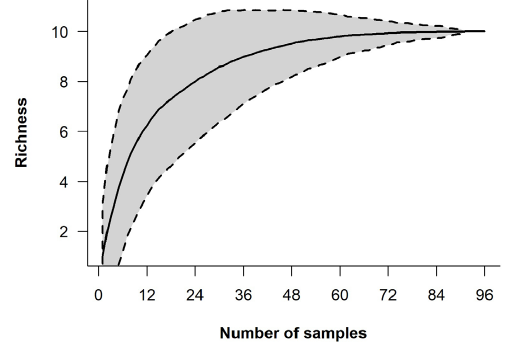
Figure 2. Cumulative richness of immature stages of Odonata (Insecta) in the Municipal Park of Lagoa do Peri (PMLP; Santa Catarina Island, southern Brazil). The grey shaded area within the dotted lines indicate 95% confidence intervals of the estimated values.